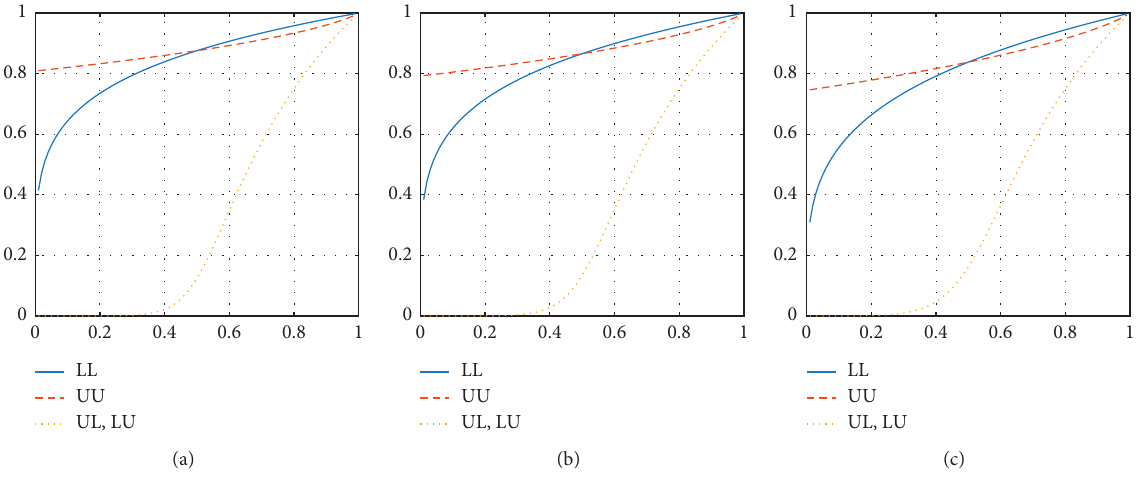
Figure 11: QD curves of bivariate Gumbel copula model. (a) HSI-CEI. (b) HSI-CCI. (c) CEI-CCI.